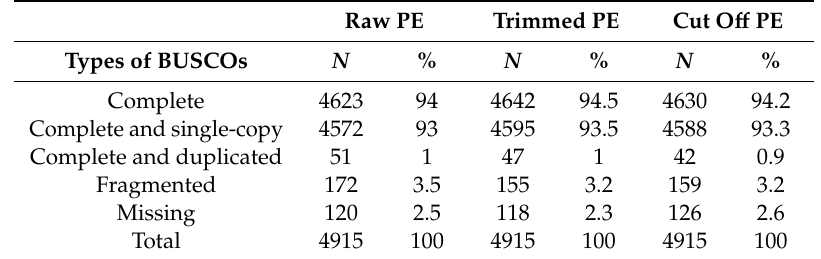
Table 5. Assembly completeness of three PLATANUS-assembled genomes based on BUSCO analyses.